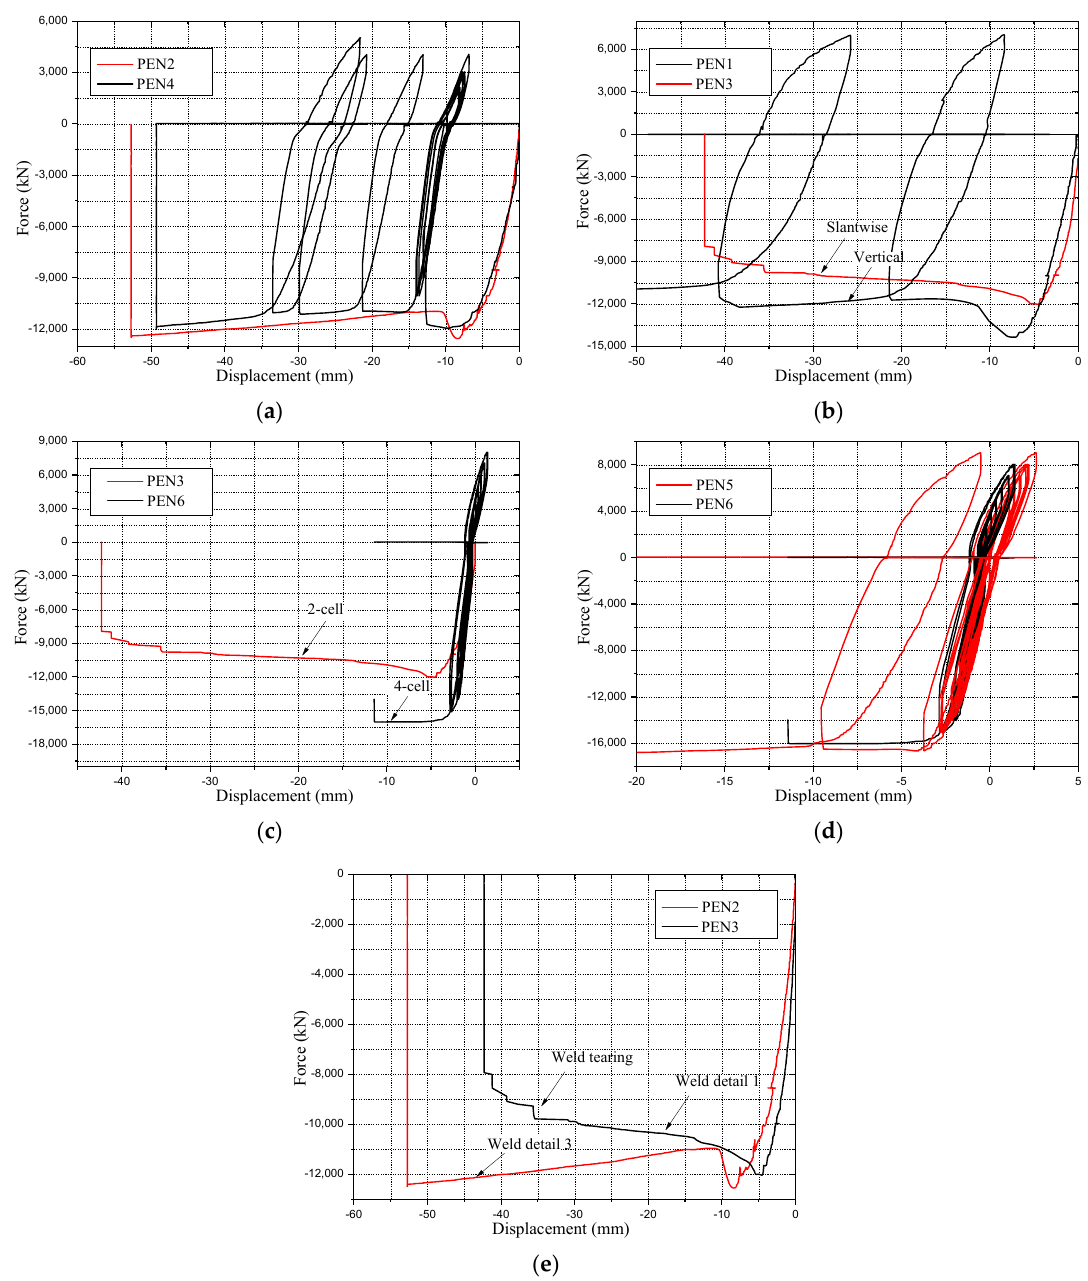
Figure 8. Axial performance of the tested specimens with different parameters. ( a ) Cyclic and monotonic loaded specimens; ( b ) Vertical and slantwise loaded specimens; ( c ) 2 ‐ cell and 4 ‐ cell specimens; ( d ) Samples with different internal weld details; ( e ) Samples with different corner weld details.